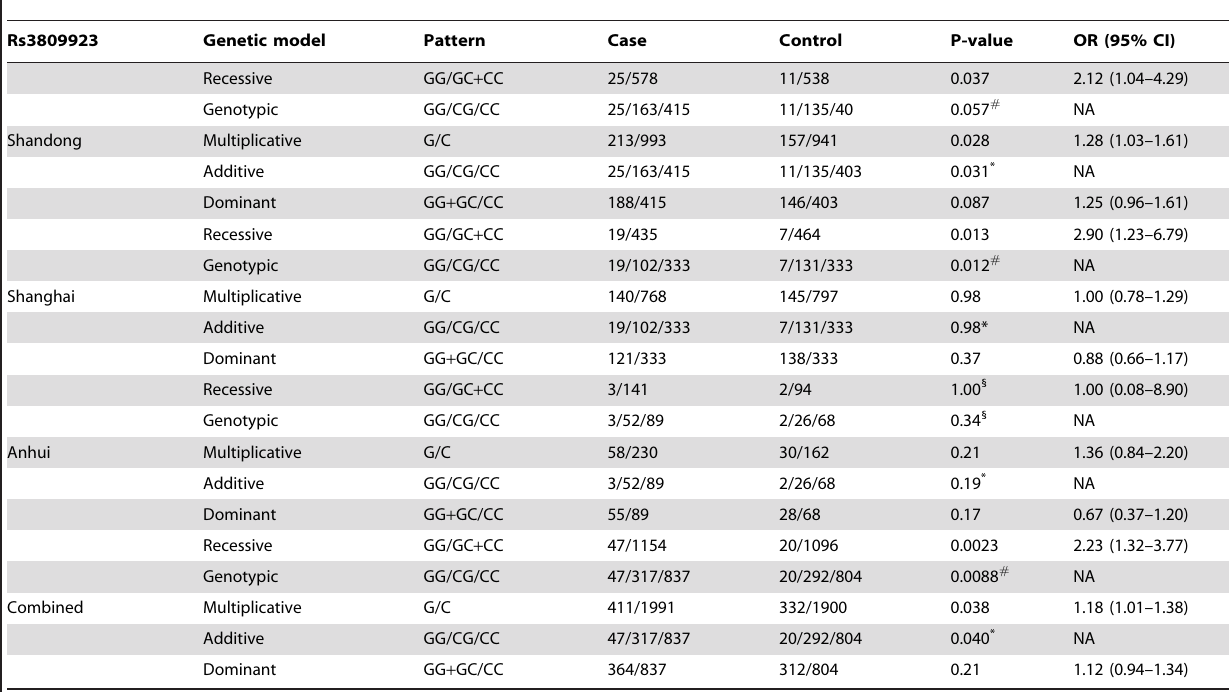
Table 3. Association of SMAD7 rs3809923 variant with CHD in 3 independent case-control studies.